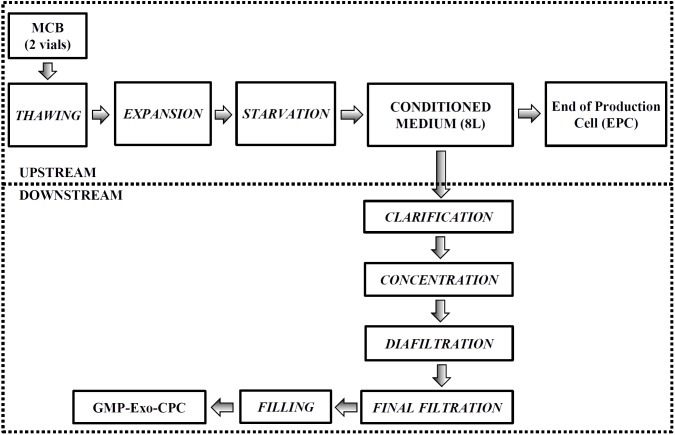
Large-scale GMP-Exo-CPC production chart. The upstream and downstream processes are grouped by the dotted boxes. See Section “Materials and Methods” for details.